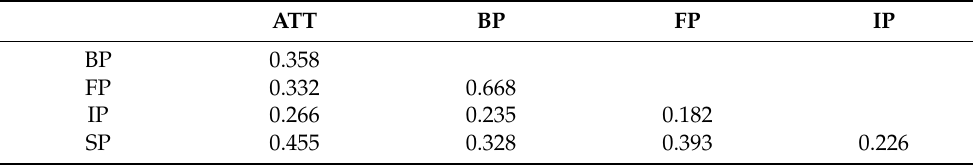
Table 3. Heterotrait-Monotrait Ratio